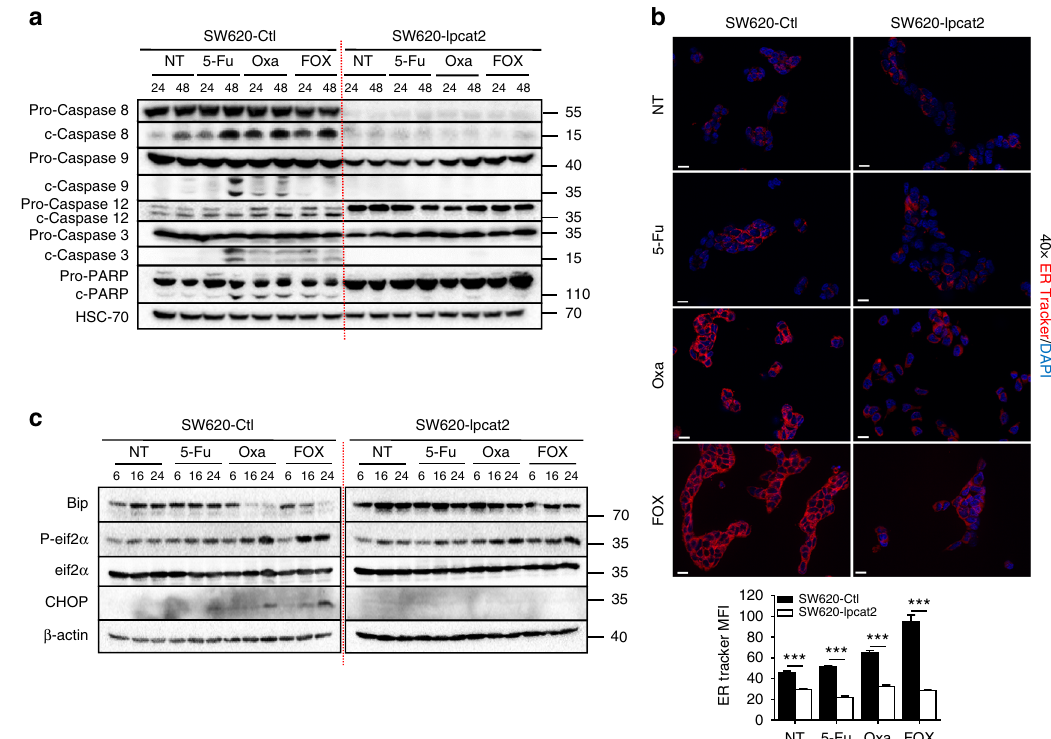
Fig. 5 LPCAT2-induced LD accumulation blunts chemotherapy-induced ER stress. a Impact of LPCAT2 on chemotherapy-induced cell death pathways in SW620-lpcat2 vs. SW620-Ctl cells after 24 and 48 h of treatments. A representative blot of pro- and cleaved forms of caspases 8, 9, 12, 3 and PARP is shown from three independent experiments. HSC-70 was used as loading control. b ER tracker staining was performed 24 h after chemotherapy treatments. Representative images of three independent experiments are shown (×40 magni fi cation, scale bar = 20 µ m) (upper panel). ER tracker median of fl uorescence intensity (MFI) was calculated in three independent experiments (300 cells per condition) (lower panel). P values were determined by the multiple Student t test. *** p < 0.001. Error bars denote s.e.m. c Western-blot analysis of ER stress markers Bip, CHOP, P-eif2 α and total eif2 α in SW620- lpcat2 and SW620-Ctl cells after 6, 16 and 24 h of chemotherapy treatments. β -actin was used as loading